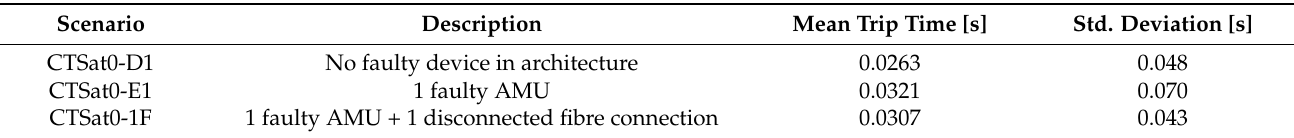
Table 9. Trip times for 3-phase-to-ground fault.